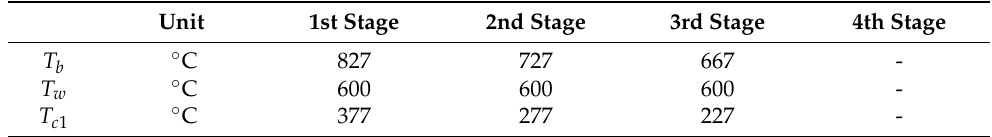
Table 3. Main parameters in each stage’s thermodynamics calculation.